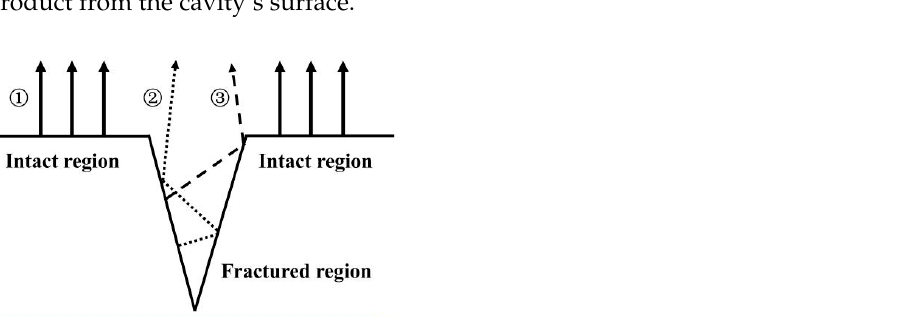
Figure 7. Schematic for the entire observation area with the radiation transmission model of the cavity effect.